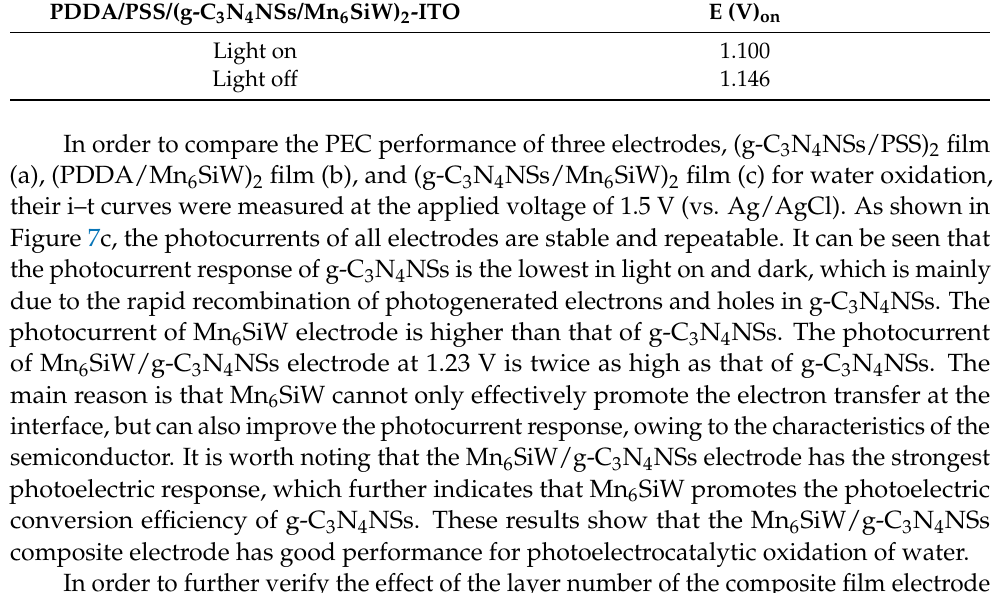
Table 3. Reported polyoxometalate modified C 3 N 4 catalysts used to catalyze water decomposition.